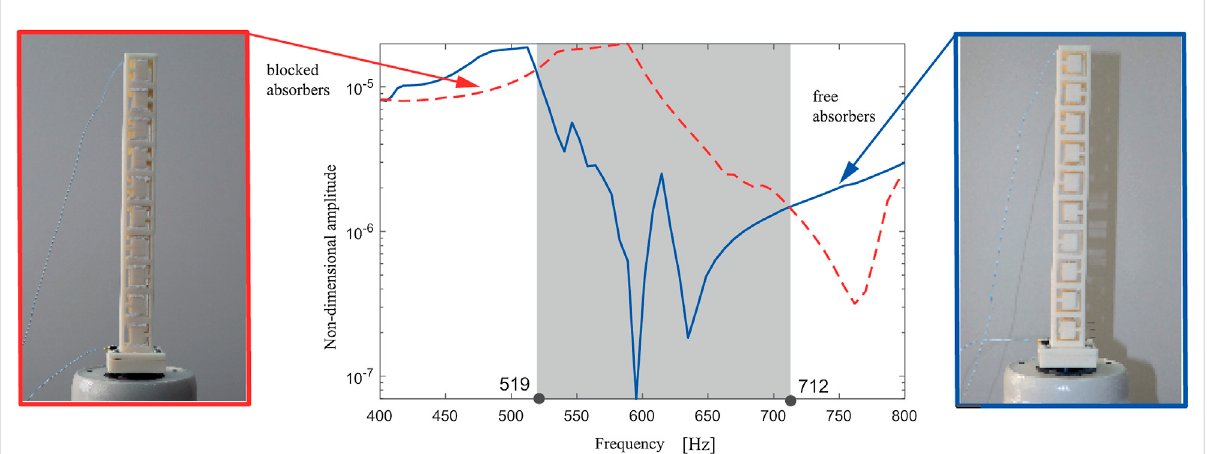
FIGURE 10 Experimentally obtained amplitude-frequency response curve of the metastructure with 10 blocked (red dashed line) and free (blue solid line) internal oscillators.